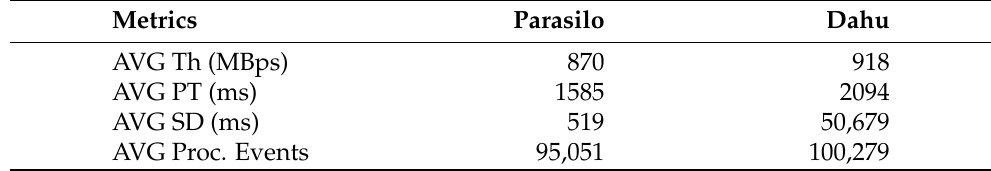
Table 6. Performance Indicators of Stateful SUMServer Application—Pipeline 1 without Backpressure.